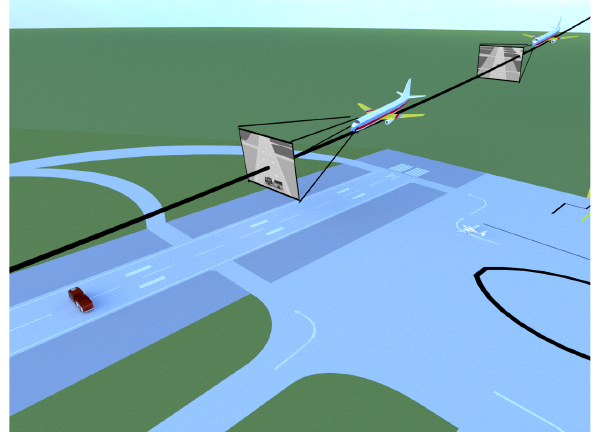
Figure 7. A pair of images used for the detection of